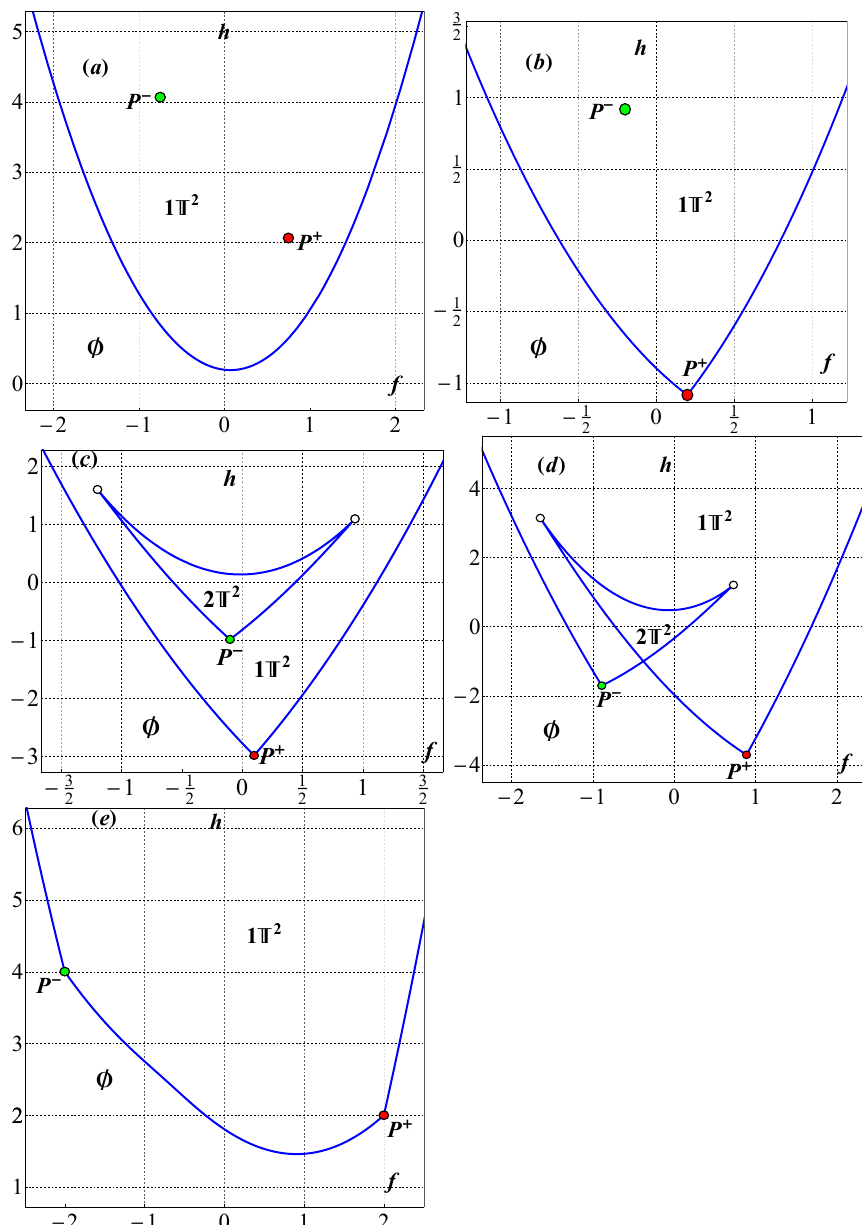
Figure 2. The regions marked with the empty set correspond to the points of the ( f , h ) -plane in which there are no possible motions. The points of bifurcation curves correspond to the critical values of the momentum map, which are the images of critical points of rank 1 (periodic motions). The regions of the ( f , h ) -plane marked with 1 T 2 or 2 T 2 correspond to the values of the first integrals for which preimage of the momentum map contains 1 or 2 two-dimensional tori, respectively. Points P + and P − correspond to focus singularities of rank 0 (equilibrium points). Qualitatively different types of bifurcation diagrams ( a – e ) are determined by the constants ( b , (cid:96) ) and correspond to the regions shown in Figure